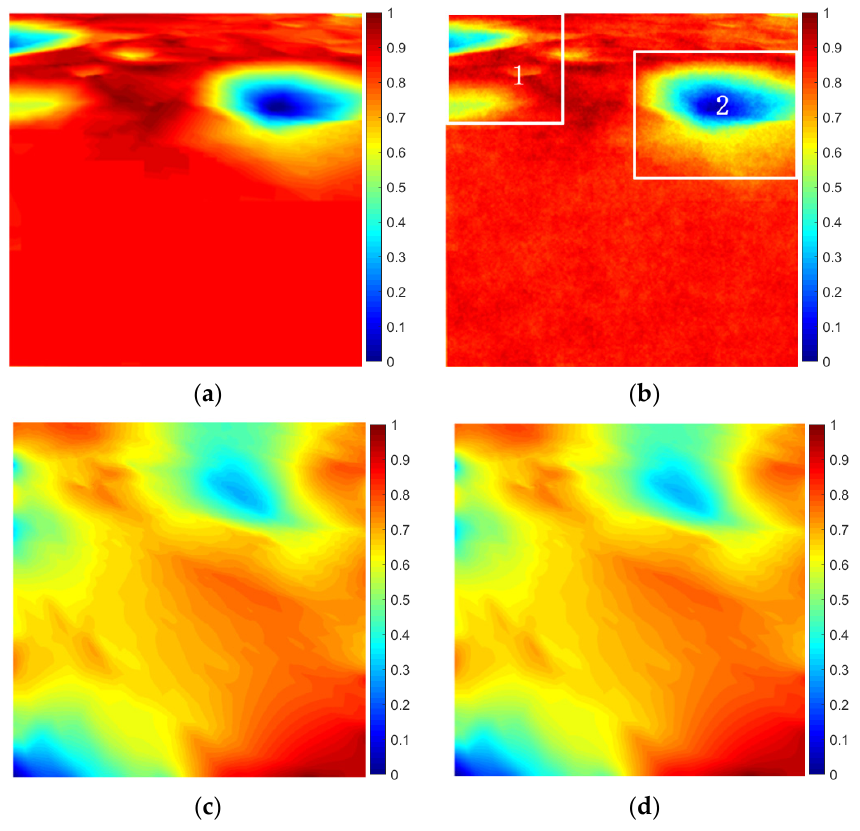
Figure 6. Height map of ground truth and results of three methods ( a ) Height map of ground truth, ( b ) PPS result, ( c ) PSPP result, ( d ) PSOP result.